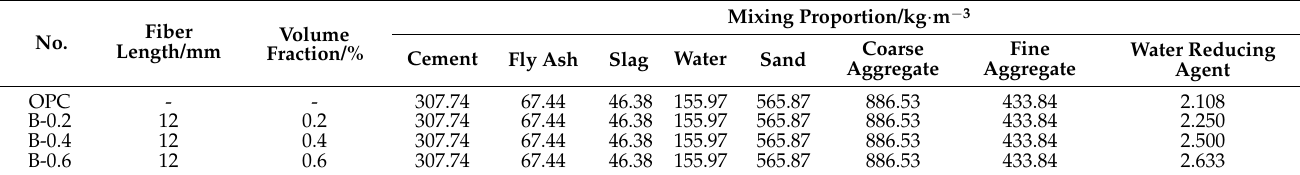
Table 1. Mixing ratio of airport pavement concrete.